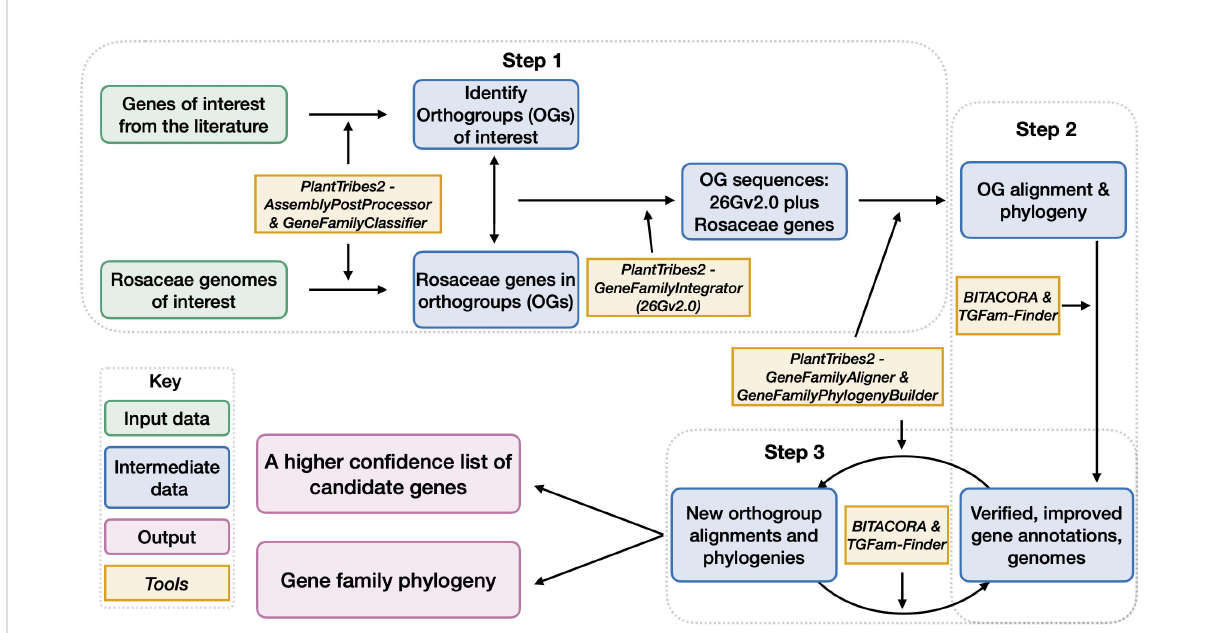
FIGURE 2 A work fl ow for candidate gene identi fi cation, curation, and gene family construction. Gray dotted boxes outlined the three steps of this work fl ow. Boxes with green outlines are input information. Boxes with blue outlines are intermediate outputs and boxes with purple outlines are fi nal outputs. Contents in boxes with orange outlines are software used for generating the